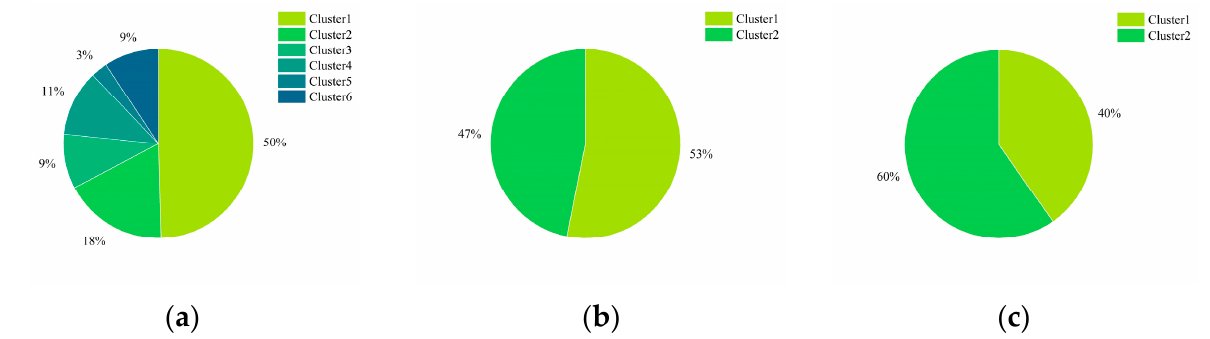
Figure 7. The accounted percentage of different heating patterns in Hebei’s bedrooms (( a ). Early heating period; ( b ). mid heating period; ( c ). late heating period).